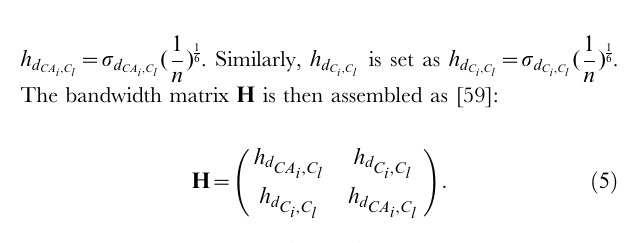
Figure 2. The time cost of energy calculations for generating one single loop. (A) The plot of computing time versus protein size show a large time saving of ‘‘Redcell-On’’ (red solid curve) compared to ‘‘Redcell-Off’’ (black dashed curve) for 12-residue loops, and (B) The plot of 6-residue loops. (C) Plot of computing time versus protein size show ‘‘Redcell-On’’ (red solid curve) has significantly improved computational time cost compared to ‘‘Ellipsoid-Only’’ (black dashed curve) and ‘‘Cutoff-Only’’ (green solid